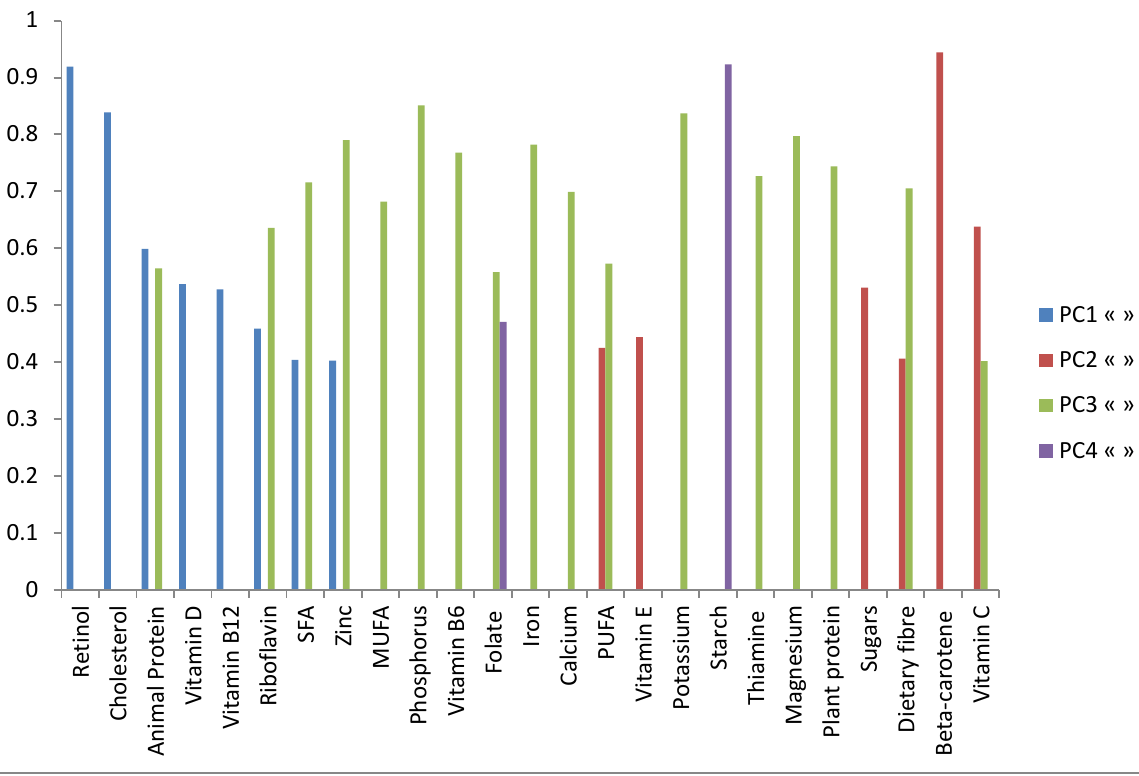
Figure 2. Plotted loadings (all > 0.4) for principal